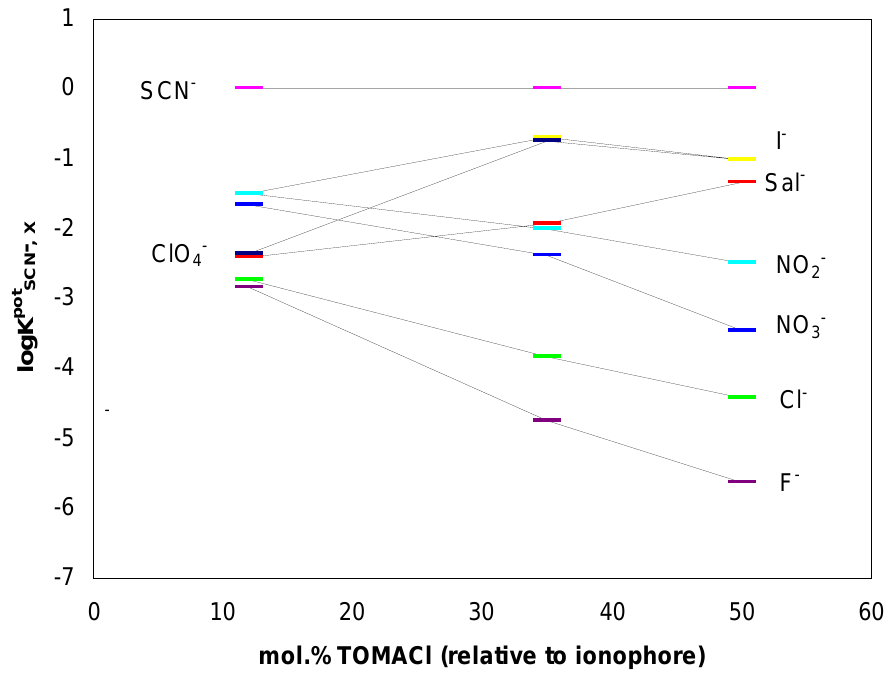
Figure 3. Selectivity coefficients, logK pot